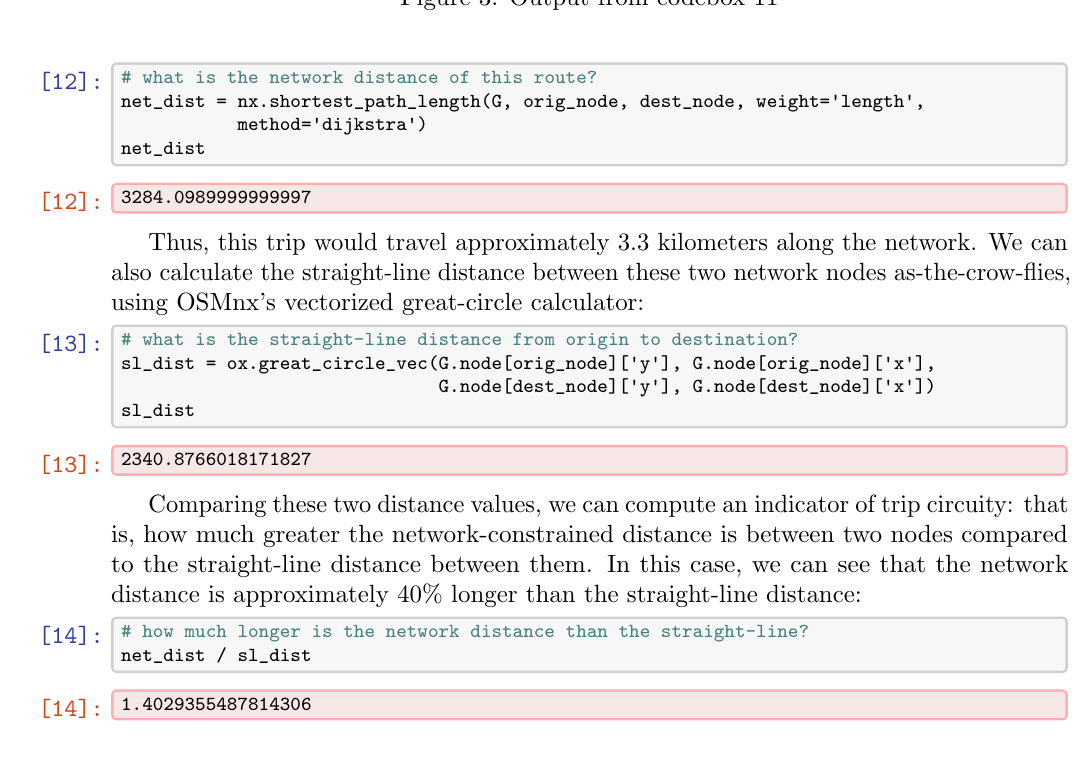
Figure 3: Output from codebox